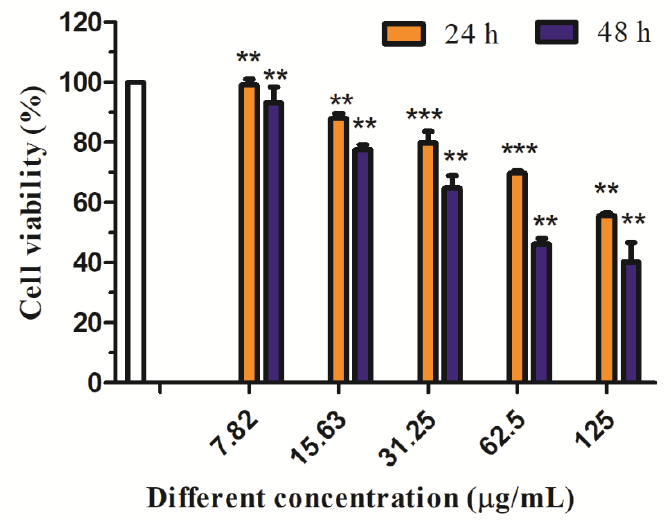
Figure 13. Effects of different treatment times with API nanoparticles on HepG2 cells ’ viability (** p < 0.05; *** p < 0.01).